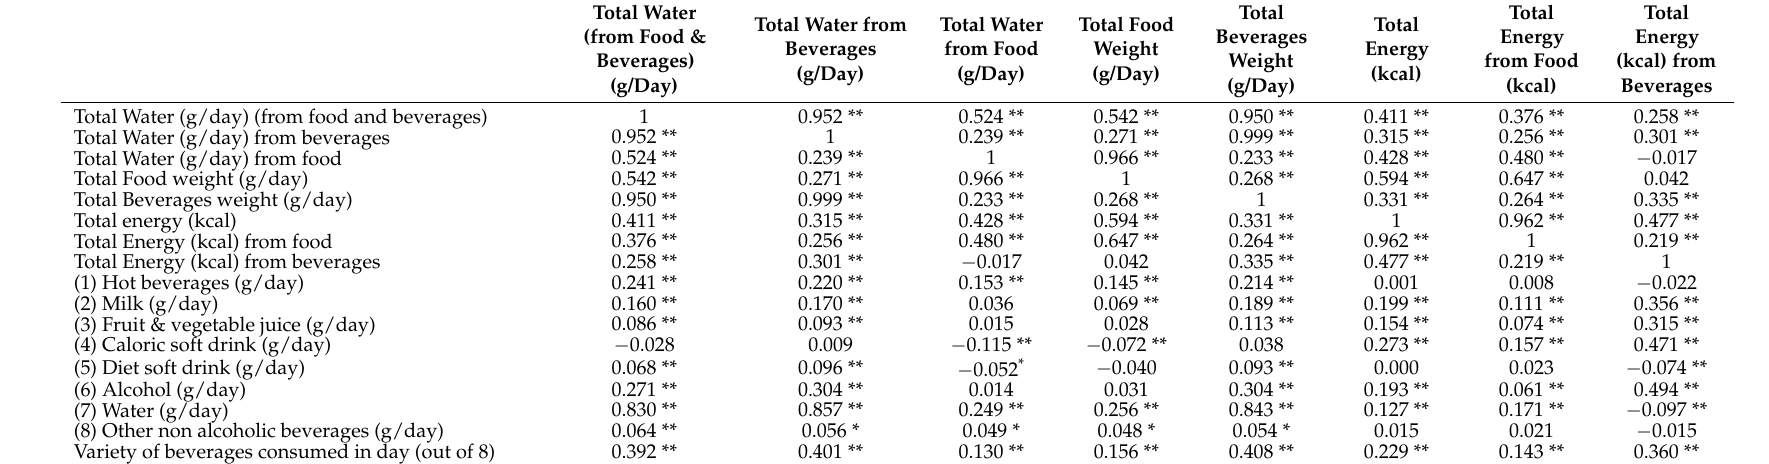
Table 4. Partial correlations between water intake, energy intake and beverage consumption. (3 days mean data adjusted for age, gender, body weight and physical